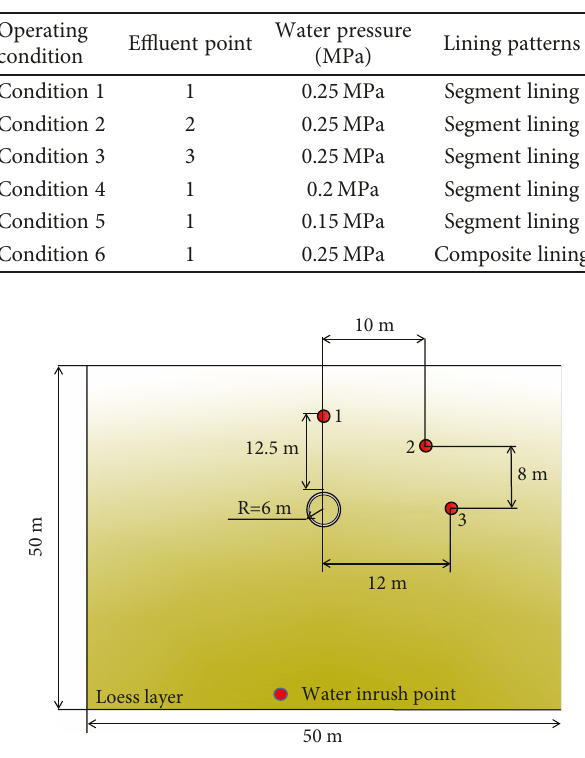
Table 4: Model operating